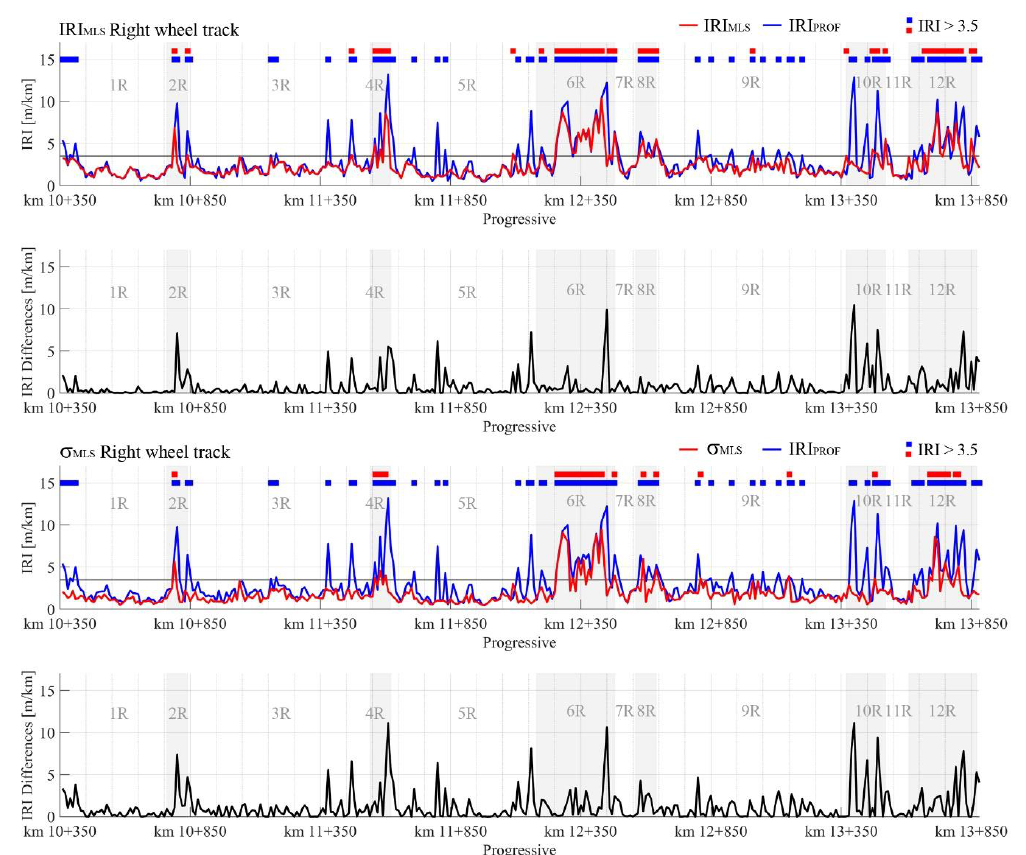
Figure 8. Right wheel track. Comparison between roughness indices: IRI MLS and σ MLS vs. IRI PROF .